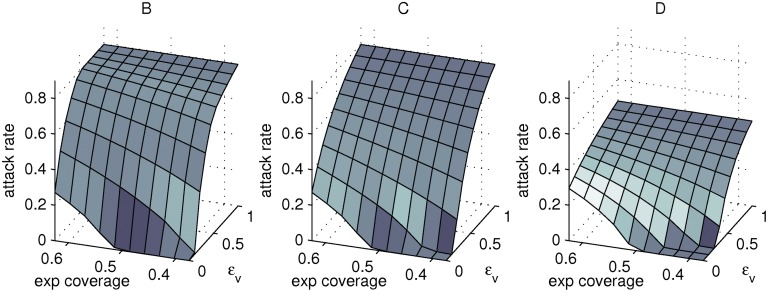
Attack rates for targeted vaccination in Scenario C.Epidemic attack rates for targeted distribution of a vaccine stockpile sufficient for 50 per cent coverage. For all epidemics the initial effective reproduction number in the absence of vaccination is fixed at 2. The axis labelled “exp coverage” denotes coverage in the experienced population and ϵ
v is the relative infectiousness of vaccinated and unvaccinated naïve hosts. The minimum plotted value of “exp coverage” indicates full coverage in the naïve population with the remainder given to experienced hosts, the maximum plotted value is for a scenario in which all vaccines are given to experienced hosts, and a value of 0.5 indicates equal coverage in naïve and experienced hosts (i.e. general population distribution). Panels represent estimates for different pre-pandemic immunity and vaccine action scenarios; 80 per cent of the population with naturally acquired CTL-mediated immunity (f
E = 0.8) and saturating vaccine action (scenario B), the same population with a vaccine that boosts protection in all hosts (scenario C), a population in which 50 per cent of those with naturally acquired CTL responses also have protective antibody to the pandemic strain and vaccine action is again boosting (scenario D). The strength of naturally acquired CTL-mediated immunity is set to ϵ = 0.5.